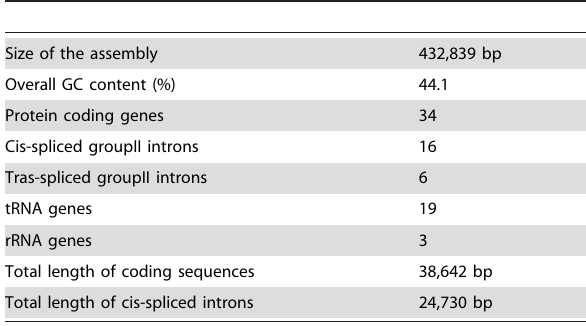
Table 3. Main features of the assembled F. rimosivaginus mitochondrial